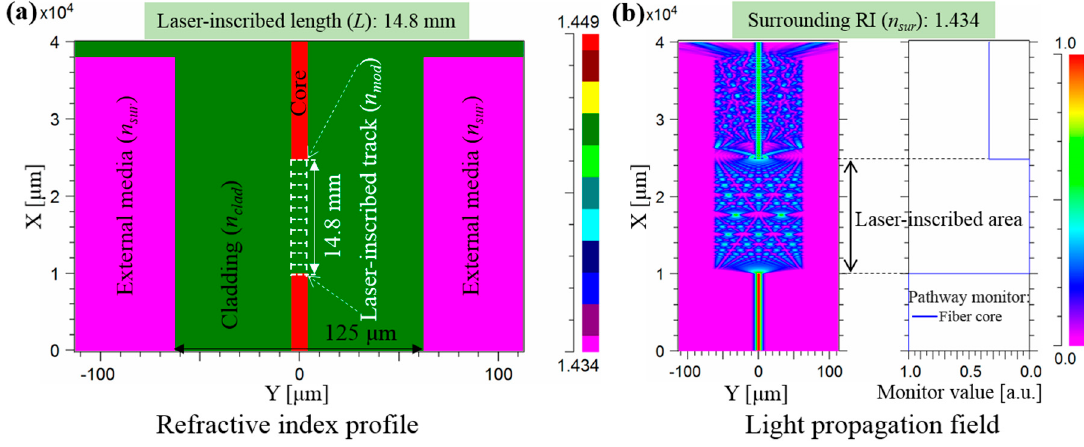
Figure 2. ( a ) Architecture and the corresponding index profile of the proposed RI sensor. ( b ) Light propagation behavior for the reshaped SMF for a surrounding medium of n sur = 1.434.